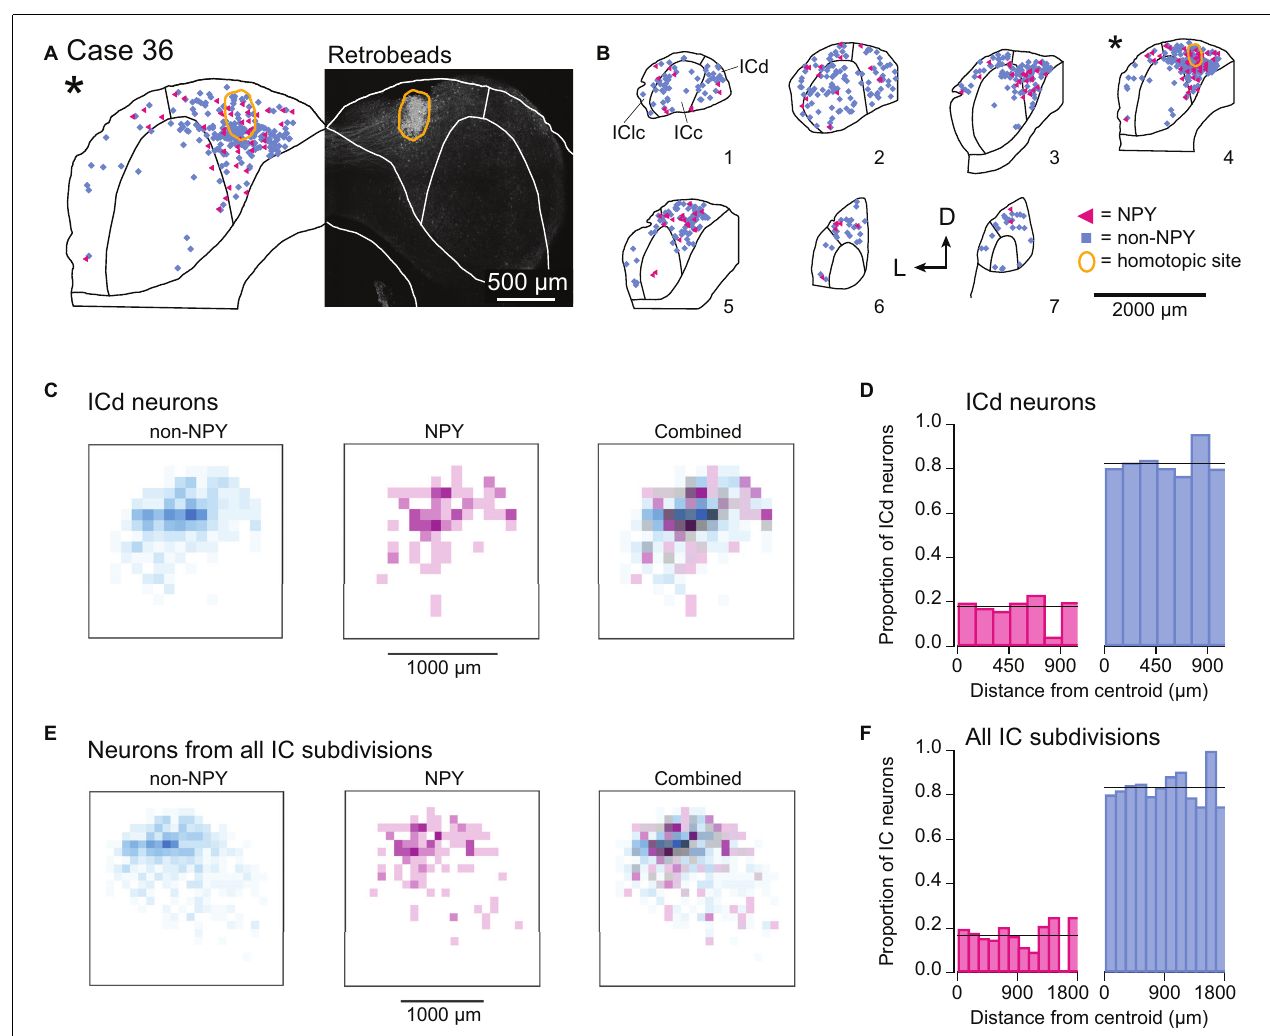
FIGURE 8 | NPY and non-NPY neurons in the ICd have similar commissural projection patterns. Results from Case 36 where the RB injection was constrained to the right ICd. Panels (A,B) show the tracer deposit and distributions of labeled cells as in Figure 3 . (A) RB deposit site in the right ICd and homotopic site in the left IC in experimental Case 36. The gray-scale image shows the center of the RB deposit (circled in gold). The left half of the panel shows an outline of the left IC with the homotopic location of the injection site indicated by the gold outline. The illustrated section (*) is from a series of sections shown in (B) . (B) The full series of plots for Case 36 showing the distributions of RB-labeled (commissural) neurons that were NPY+ (magenta triangles, n = 119 neurons) and non-NPY (cyan squares, n = 598 neurons). Sections are numbered from caudal to rostral. The asterisk indicates the section containing the injection site shown in (A) , and the area homotopic to the injection is outlined in gold. RB-labeled neurons were distributed throughout the ICd, including at the site homotopic to the injection site. D—dorsal; L—lateral. (C) Heatmaps show the densities of non-NPY commissural neurons (cyan, left) and NPY commissural neurons (magenta, middle) in 100 µ m 2 bins in the left ICd. In contrast to the ICc injection cases, a merged overlay of the non-NPY and NPY densities (right) reveals that RB-labeled NPY and non-NPY neurons had largely overlapping distributions in the ICd. (D) For neurons located in the ICd, the proportions of RB-labeled NPY and non-NPY neurons in 150 µ m bins relative to the centroid were calculated following the same procedure as in Figure 6 . The proportion of NPY neurons in the 0–150 µ m bin was slightly higher than the overall mean proportion, in contrast to what was observed for the ICc injection cases. (E,F) Same analysis as in (C,D) except that RB-labeled neurons from all IC subdivisions were included in the analysis. The results again show more overlap of labeled NPY and non-NPY neurons near the injection site (E) , with the proportion of NPY neurons in the 0–150 µ m bin again being slightly higher than the overall proportion of labeled NPY neurons (F)